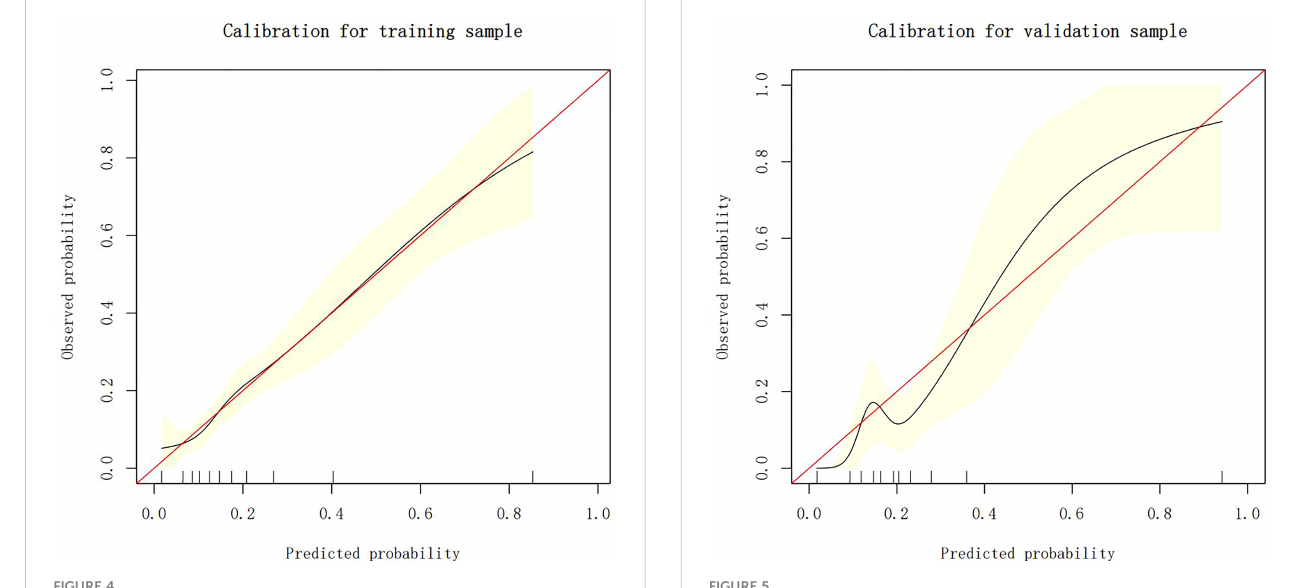
FIGURE 4 The calibration plots of the training set by LR. LR, logistic regression.